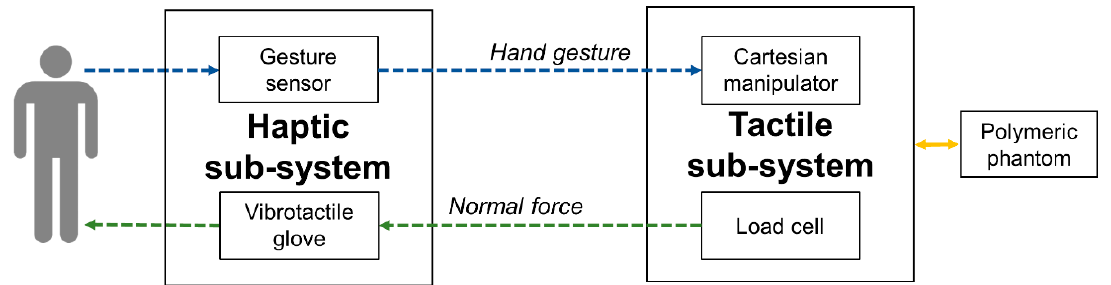
Figure 2. Block diagram: bidirectional data streaming between the haptic and tactile sub-systems provided via UDP: the optical controller conveyed speed and position of the center of mass of the user’s hand from the first environment to the cartesian manipulator in the remote one (blue arrow) and, while sliding, normal force data collected by the load cell from the platform to the vibro-tactile glove to deliver the spike-based stimulation (green arrow).